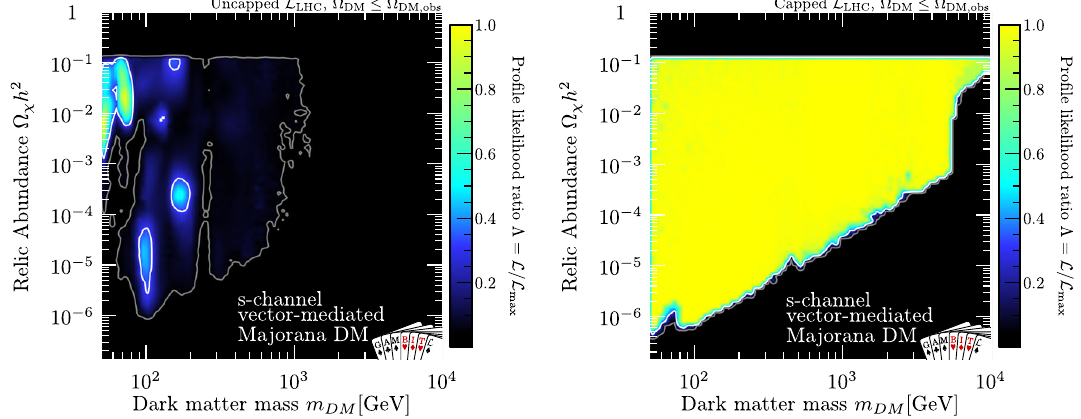
Fig. 9 Relic density of the Majorana fermion DM model, allowing the model to underproduce the relic abundance. Capped collider results are shown on the right. As with the Dirac model, we do not show the